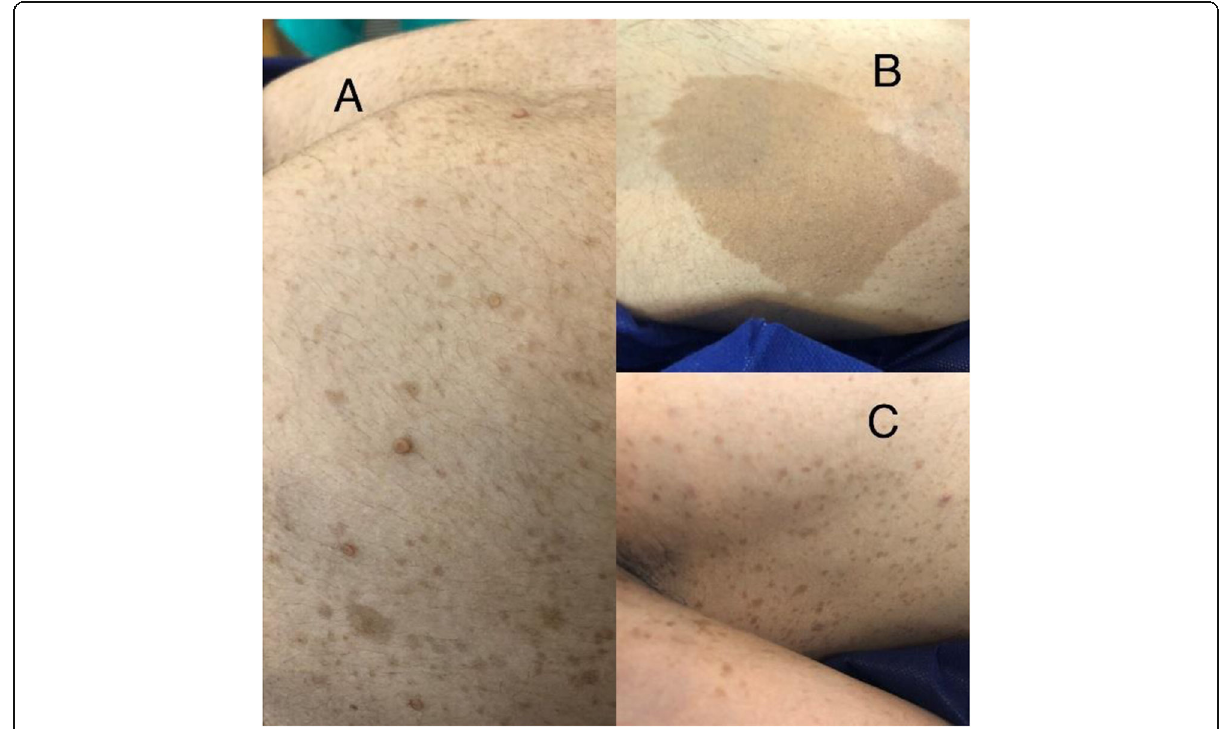
Fig. 1 Patient ’ s physical exam revealed a multiple neurofibromas, b café-au-lait spots, and c axillary